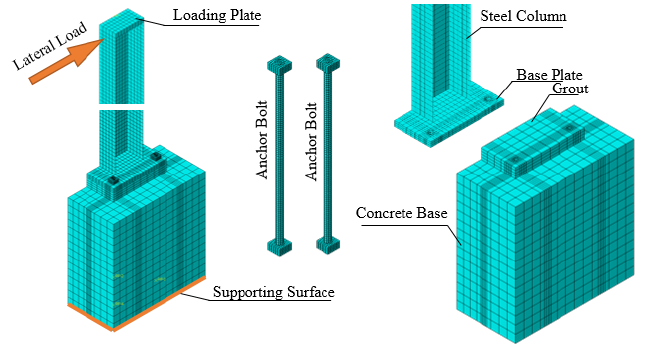
Figure 2. Finite Element Model.